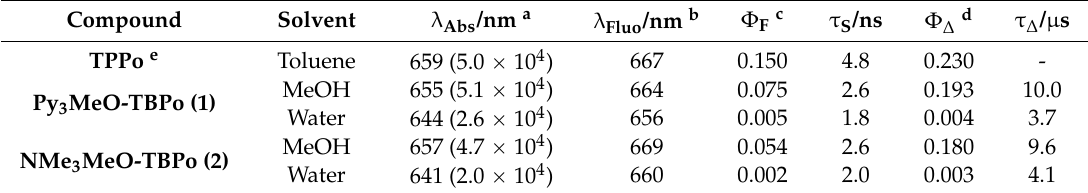
Table 1. Summary of photochemical properties of the porphycenes under study. Compound